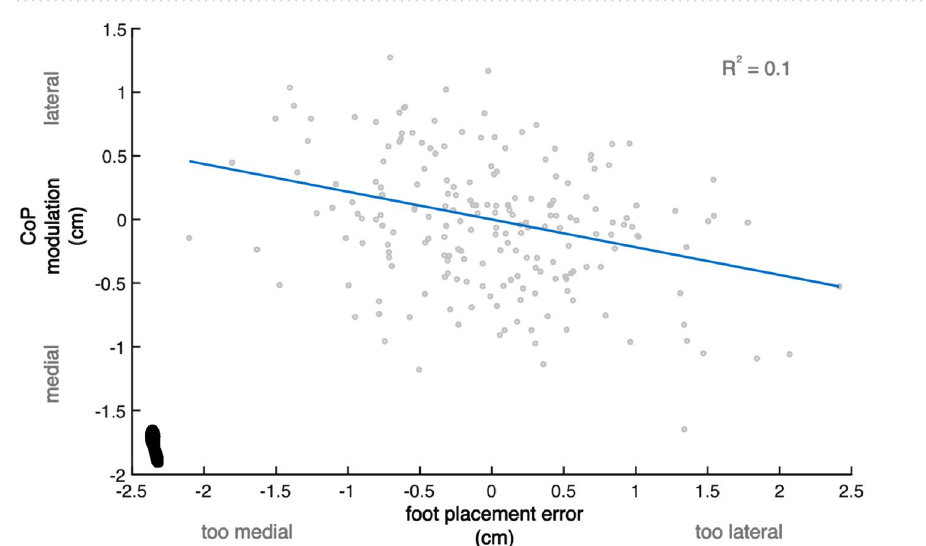
Figure 4. Relationship between foot placement error and subsequent CoP shift. Example of one participant, demonstrating a negative relationship between CoP modulation (ankle moment control) and foot placement error. The blue line represents the fitted model (2) and the data points represent individual (right and left) steps. The foot print represents the steady-state walking condition (see Table 1). Compared to the other participants, this participant demonstrated a relatively high relative explained variance (R 2 = 0.1). This figure was created using Matlab 2021a (https:// www. mathw orks. com/ produ cts/ matlab. html) and Adobe Illustrator CC 2018 (https:// www. adobe. com/ nl/ produ cts/ illus trator.